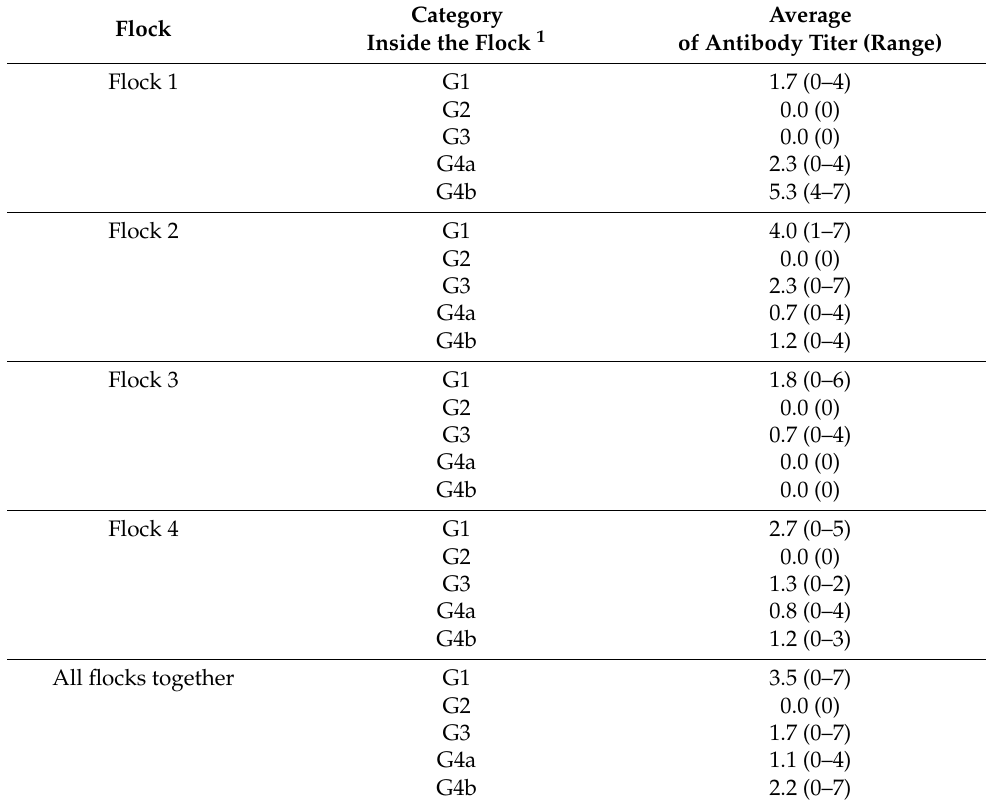
Table 2. HI-antibody titers (log 2 ) against APMV-1.